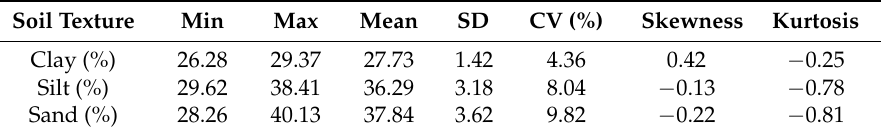
Table 2. Statistical description of the soil particle distributions of the soil samples.